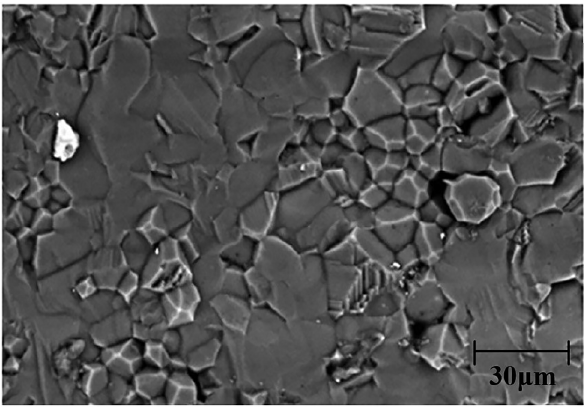
Figure 6: Surface fracture of alumina-NbC [41]